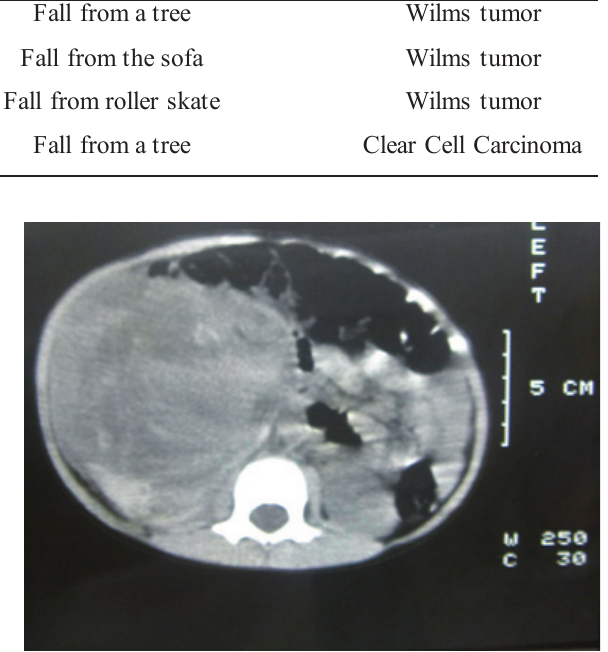
Figure 1 - CT of case 1: a large renal mass due to Wilms tumor, with intratumoral hemorrhage.